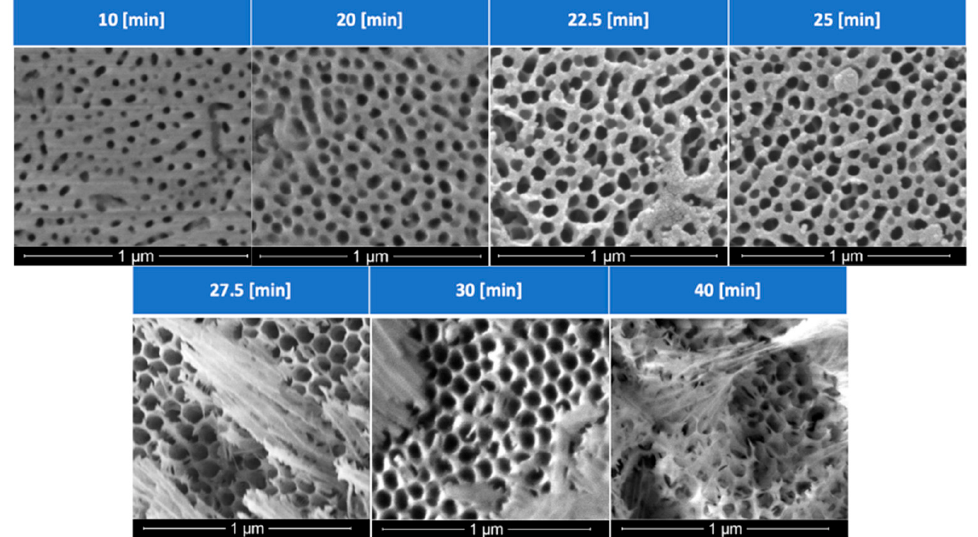
Figure 6. Effects of anodization times on the pore size and pore density of the anodic host layer. With the voltage and concentration of the solution fixed at 40 V and 1.6 M, respectively, time would not only determine the thickness of the anodic layer, but also the pore morphology. Figure 6 details the effects of anodization times: after 25 min under the mentioned experimental conditions, a more disordered and misoriented group of pores is